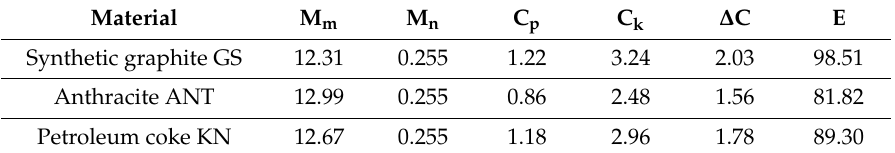
Table 5. The results of metal bath recarburization by the addition of carburizer to solid charge.